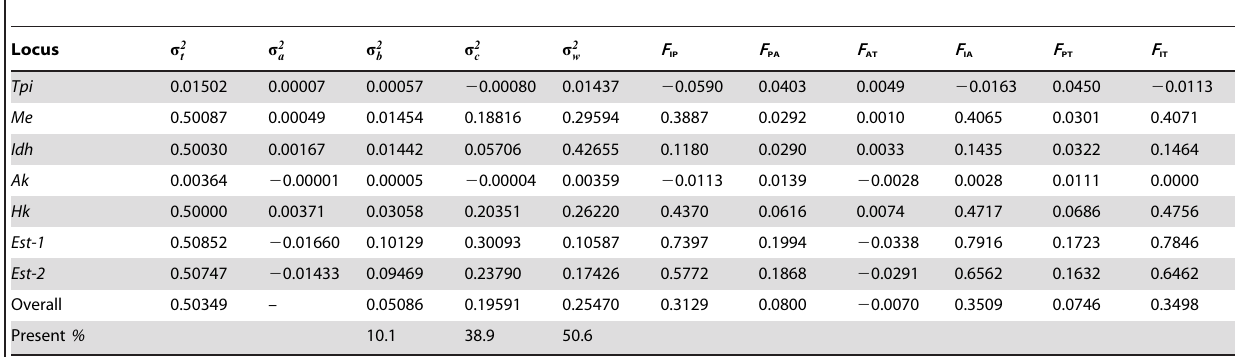
Table 2. Estimated variance components and three-level hierarchical F-statistics of the genetic variation of Agabus bipustulatus.